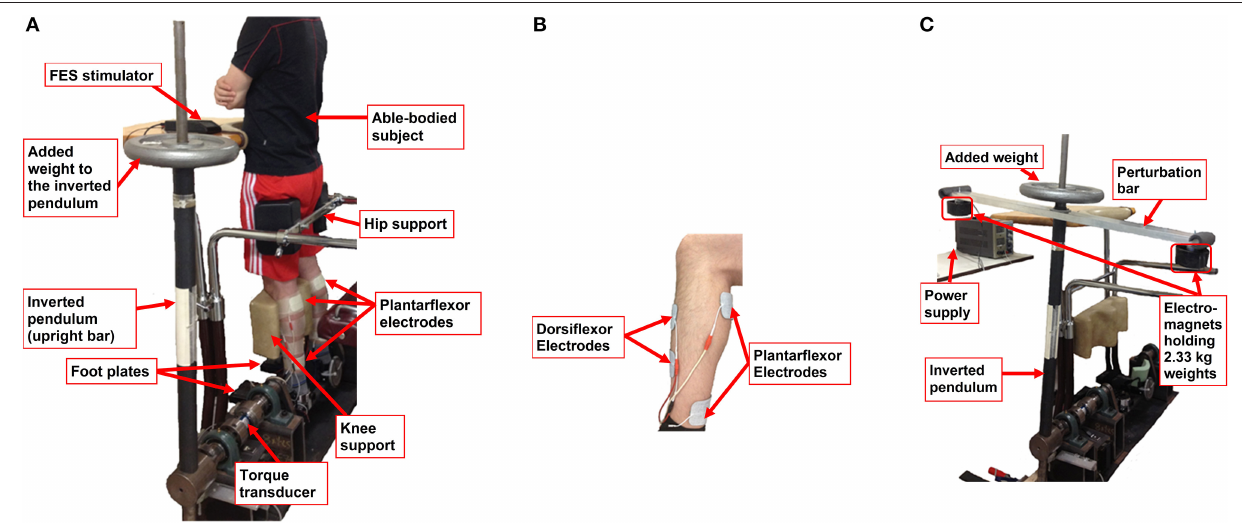
FIGURE 1 | Experimental setup: (A) Subject standing in the Inverted Pendulum Standing Apparatus (IPSA) (Same et al., 2013; Tan et al., 2014; Rouhani et al., 2016); (B) Electrode placement for bilateral application of FES for standing balance. For plantarflexors, 5 × 9 cm electrodes were applied bilaterally along the midline of the posterior calf. One electrode was placed approximately 2 cm below the popliteal fossa over the gastrocnemius and soleus muscle motor points so as to activate both gastrocnemius heads as well as the soleus muscle. The other electrode was placed around the lower end of the gastrocnemius muscle belly just above the ankle joint. For dorsiflexors, 5 × 5 cm electrodes were applied. One electrode was placed over the motor point of the tibialis anterior, just lateral to the fibula, and the other electrode was placed approximately 8 cm below the anode; (C) Experimental setup for testing the FES controller’s response to postural balance perturbation. A perturbation bar is added with weights at its two ends. Dropping of each weight at random instants induces perturbation torque applied on the inverted pendulum. This mechanism could simulate the torque induced due to arm motion in the sagittal plane during standing.